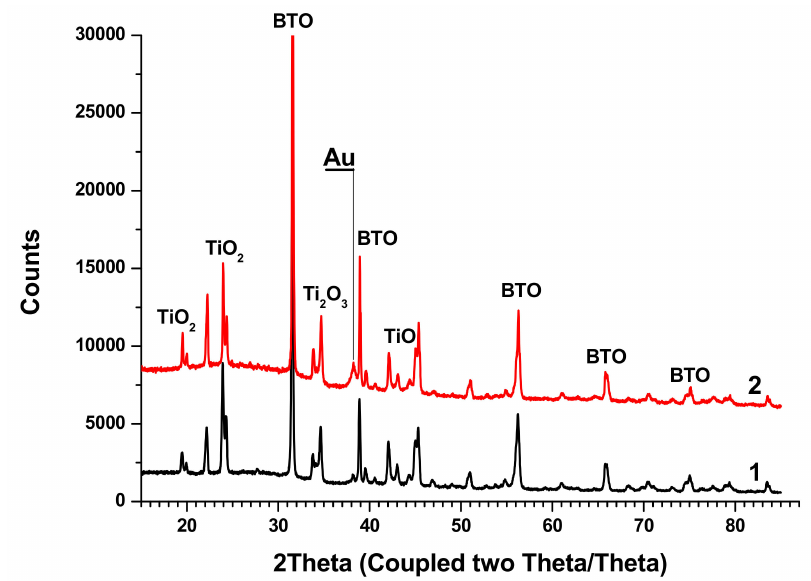
Figure 13. X-ray di ff ractograms of the composite Au-BTO NPs obtained by: laser ablation of Au target in colloidal solution of BTO NPs with 200 ns pulses (1), irradiation of the mixture of colloids of Au and BTO NPs with 200 ns pulses